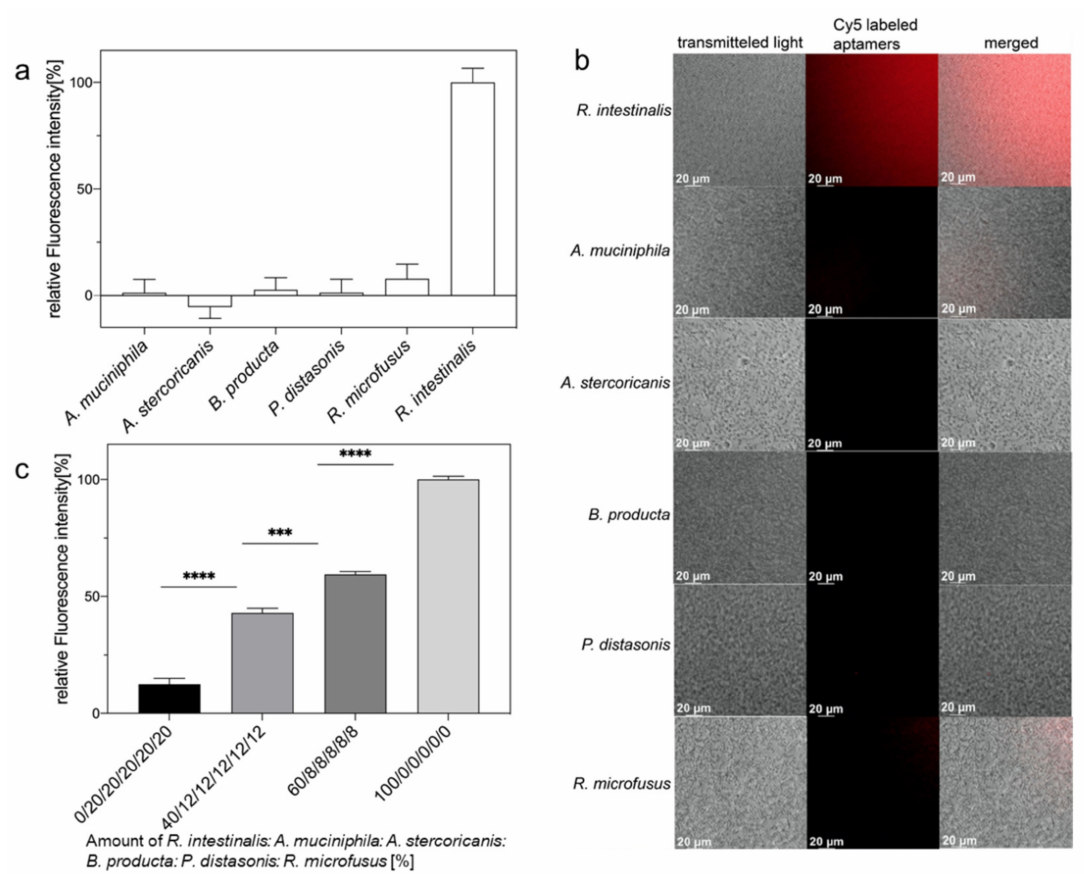
(Figure 3a). The ability of the aptamer library Ri 7_2 to discriminate R. intestinalis from a single control bacterium was verified by a labeling experiment, which used fluorescence microscopy of the individual bacterial strains. The results showed that the aptamer library Ri 7_2 specifically showed intense labeling of R. intestinalis , but ultimately failed to label the other five control bacteria (Figure 3b). Next, we adjusted R. intestinalis and five other intestinal bacteria, A. muciniphila , A. stercoricanis , B. producta , P. distasonis and R. microfusus to the same optical density and mixed them at different ratios. The final fluorescence labeling experiments showed that the increasing number of R. intestinalis in this series of samples could be tracked perfectly, and the fluorescence intensity showed a clear linear relationship with the number of R. intestinalis (Figure 3c). This shows that already with the Ri 7_2 polyclonal library labeling applications can be performed with adequate specificity and accuracy.